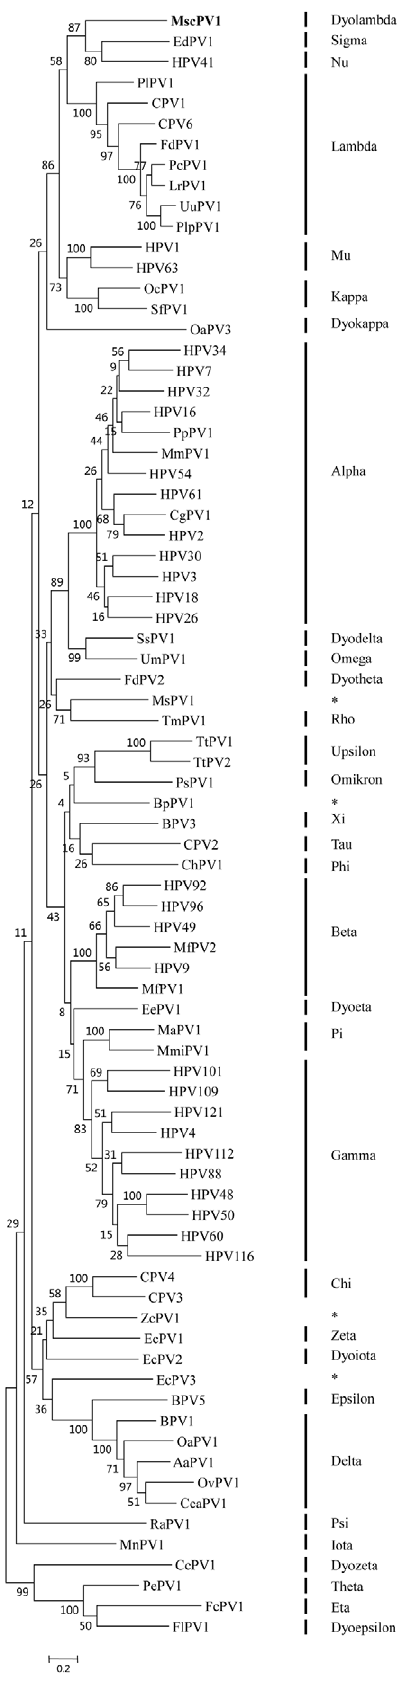
Figure 3. Maximum likelihood phylogenetic tree of the L1 nucleotide sequences of 79 PVs. The PV genus of each strain is indicated. PVs with putative PV genera that are currently unclassified are marked by asterisks. The PV discovered in this study is shown in bold. Scale bar indicates 0.2 inferred substitutions per site. AaPV, Alces alces papillomavirus; BpPV, Bettongia penicillata papillomavirus;